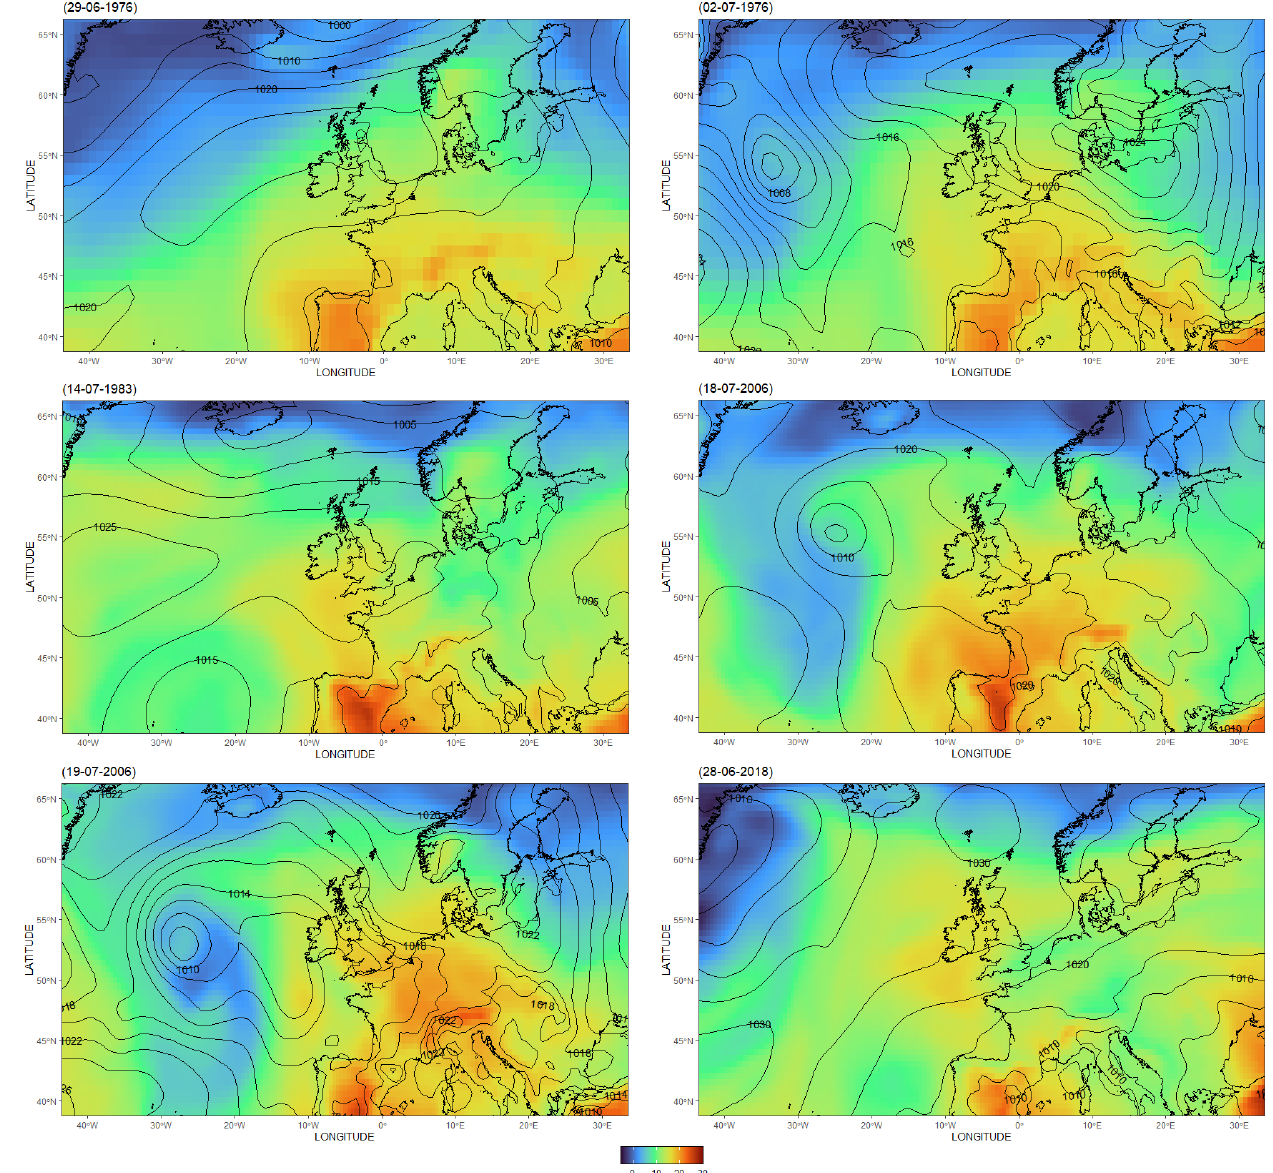
Figure 12. As Fig. 4 but for the dates of post-1900 possible record heat events as detailed in Table 2. Data provided by the NOAA/OAR/ESRL PSL, Boulder, Colorado, USA, from their web site at https://psl.noaa.gov/data/gridded/data.20thC_ReanV3.html (last access: 21 January 2022) (for NOAA 20CRv3 MSLP and 850hPa temperatures) and Hersbach et al. (2018) (for ERA5 during its period of record). The domain of latitude 35–70 ◦ N and longitude 45 ◦ W–30 ◦ E was chosen to provide a synoptic view, with Ireland centred to provide an overview of the surrounding regions. All maps correspond to 15:00UTC, which is the approximate expected time of daily maxima in Ireland (corresponding to ca.